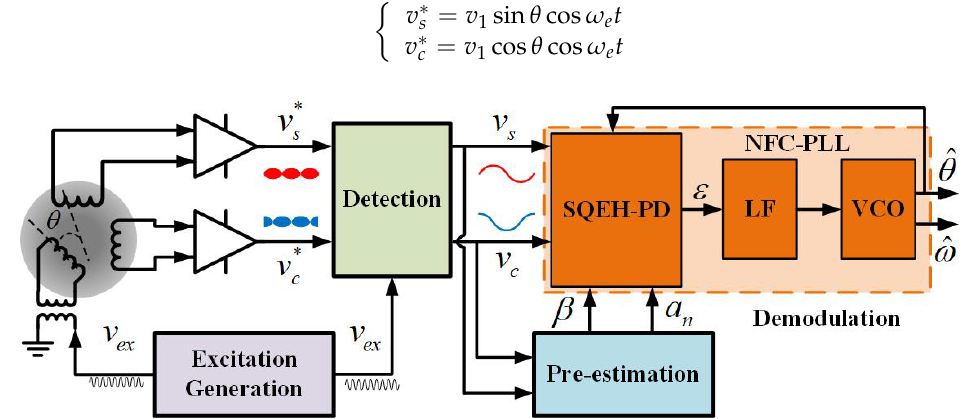
Figure 1. Schematic diagram of software-based RDC.